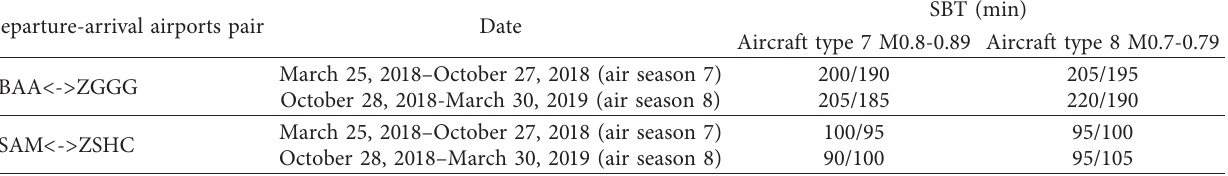
Table 1: Example of standard block times.